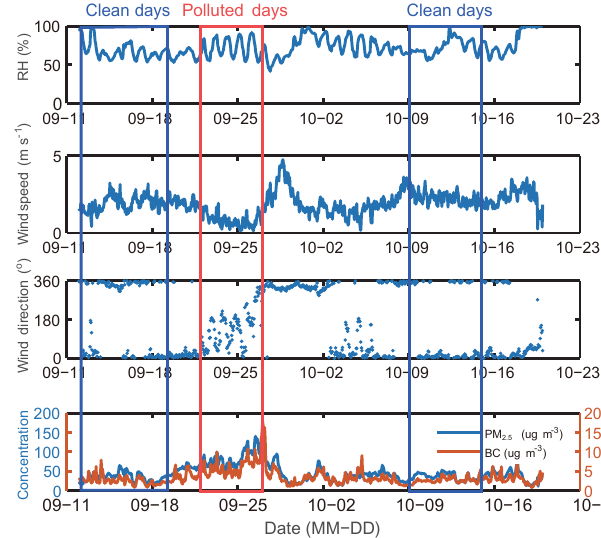
Figure 1. Time series for relative humidity, wind speeds, wind di- rections and concentrations of PM 2 . 5 as well as BC concentration (bottom